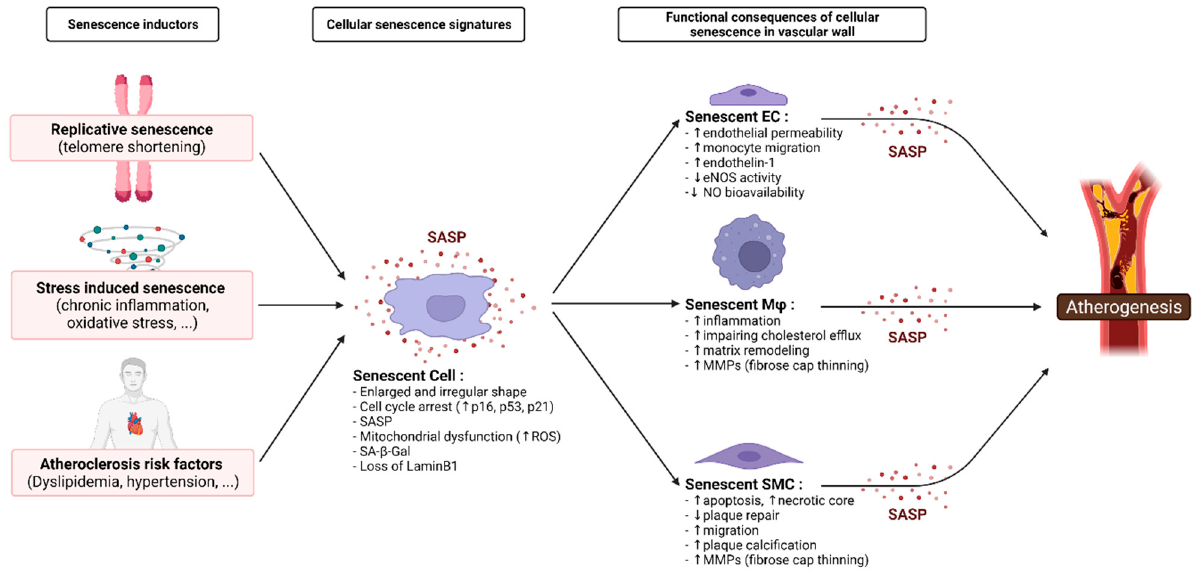
Figure 1. Role of senescence mediated-processes on the physiopathological events of atherosclerosis. Focus on vascular wall senescent cell populations; namely endothelial cells (EC), macrophages (M ϕ ), and smooth muscle cells (SMC).